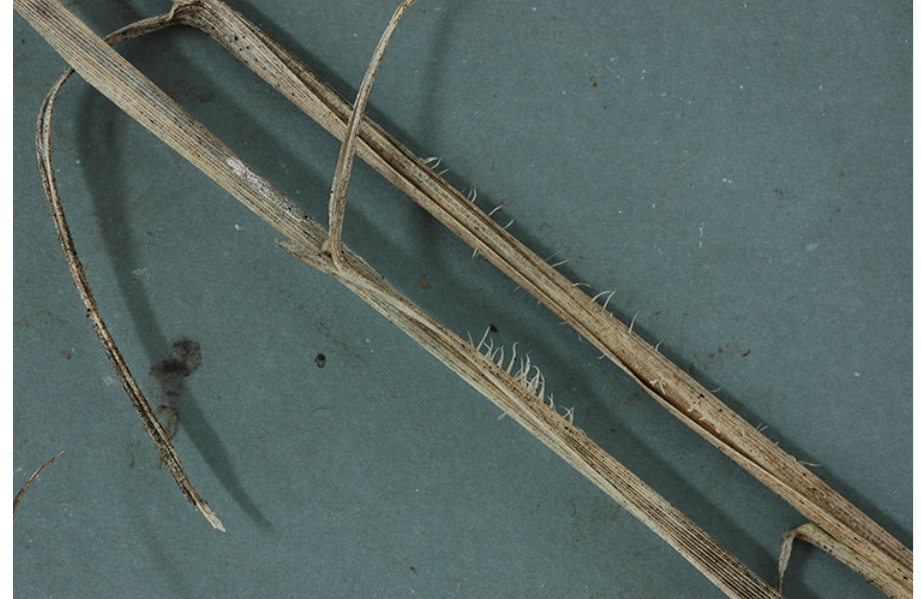
Fig. 3 Basidiomata of Pterula gracilis (Desm. & Berk.) Corner from Kampinos National Park (2018-09-09). Photography by Błażej